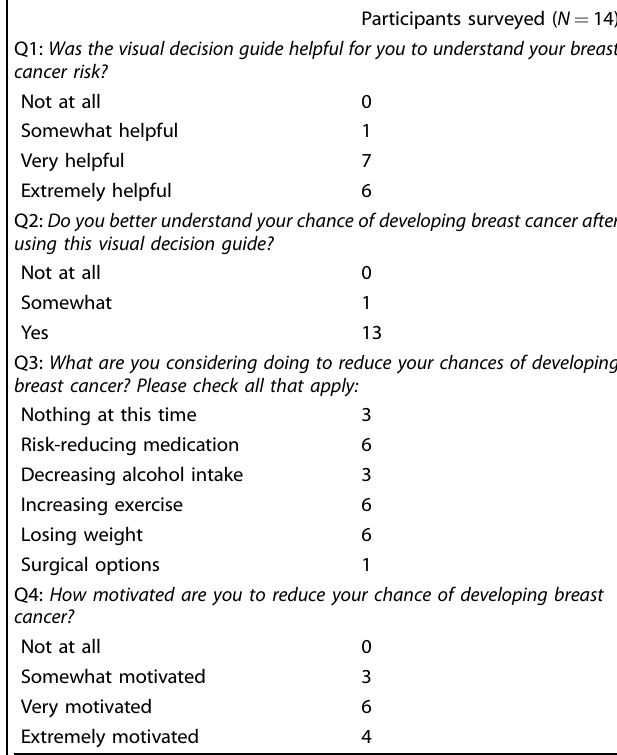
Participants surveyed ( N =